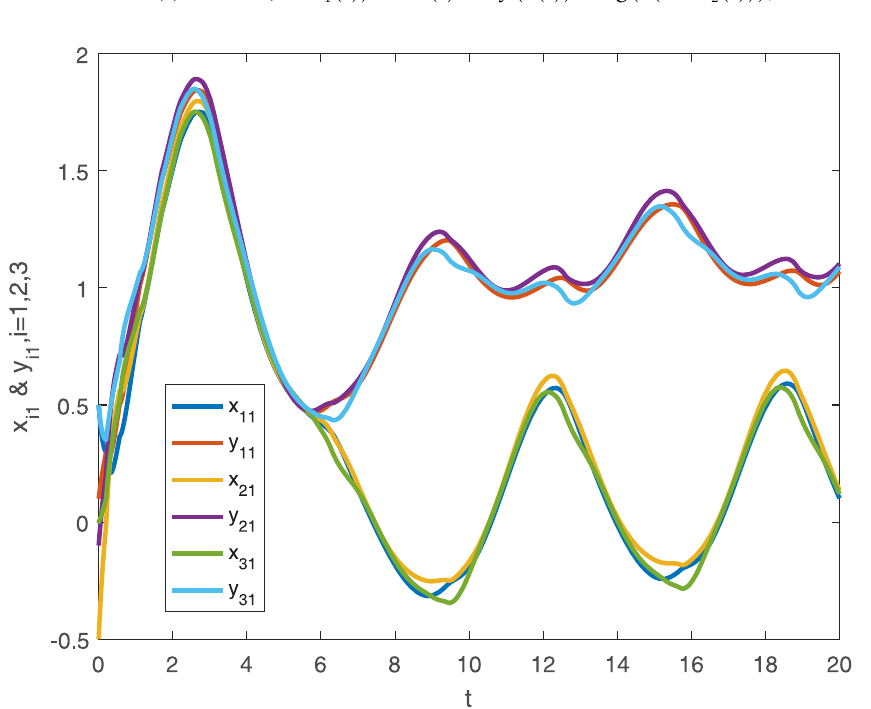
Fig 1. The first dimensional trajectories of the drive system (18) with initial conditions x 1 ( t 0 ) = [0.5 + sin ( t ), cos ( t ) − 0.5] T , x 2 ( t 0 ) = [ sin ( t )− 0.5, 0.5 + cos ( t )] T , x 3 ( t 0 ) = [ sin ( t ), cos ( t )] T and response system (19) with initial conditions y 1 ( t 0 ) = [0.1 + sin ( t ), cos ( t )− 0.1] T , y 2 ( t 0 ) = [ sin ( t )− 0.1, 0.1 + cos ( t )] T , y 3 ( t 0 ) = [0.5 + sin ( t ), cos ( t )− 0.5] T when no controller